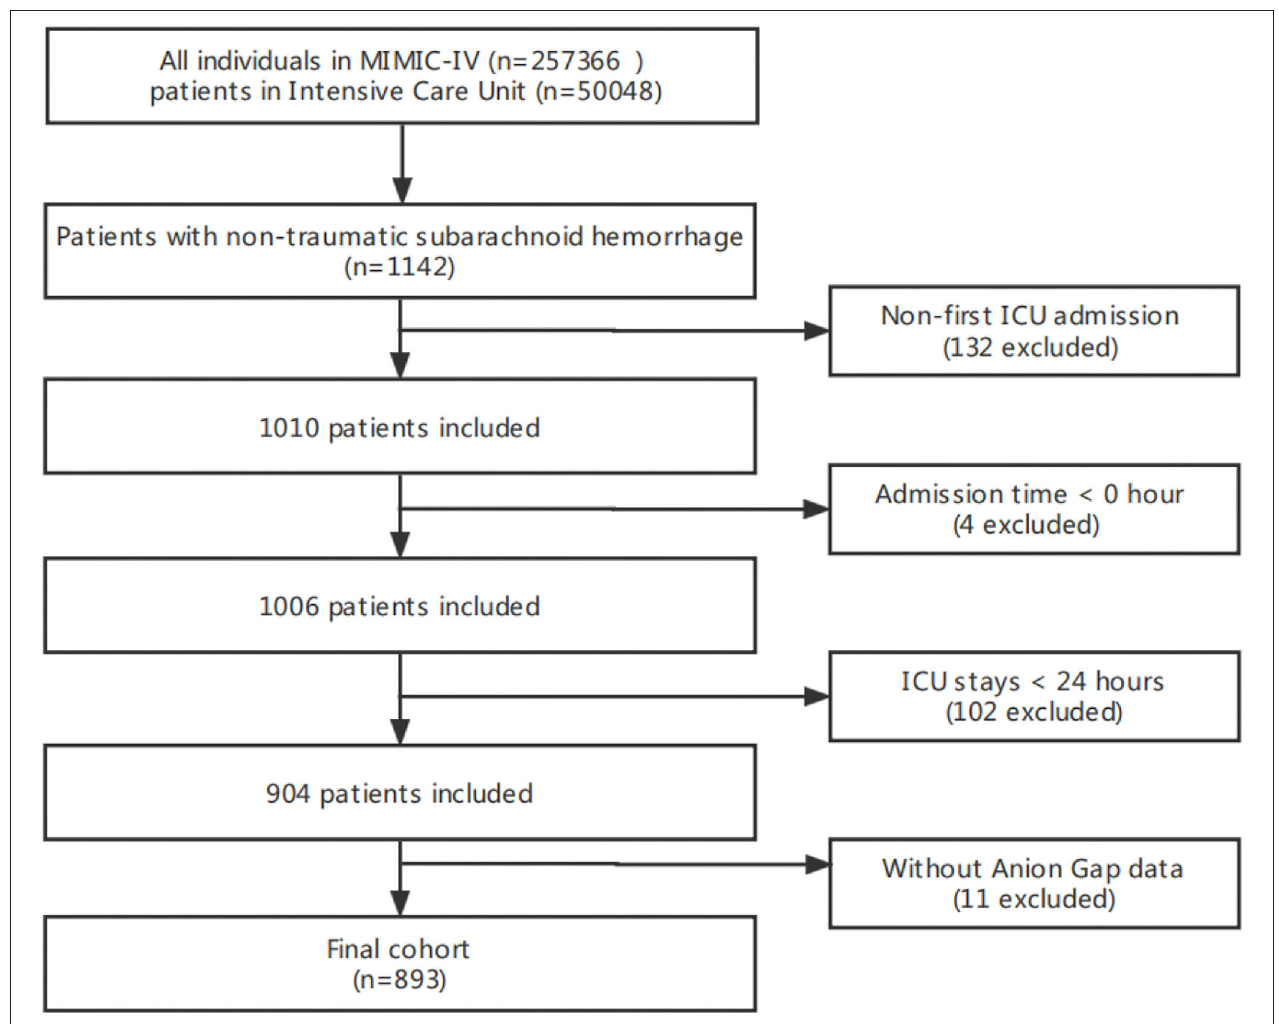
FIGURE 1 | A flowchart of study patients.